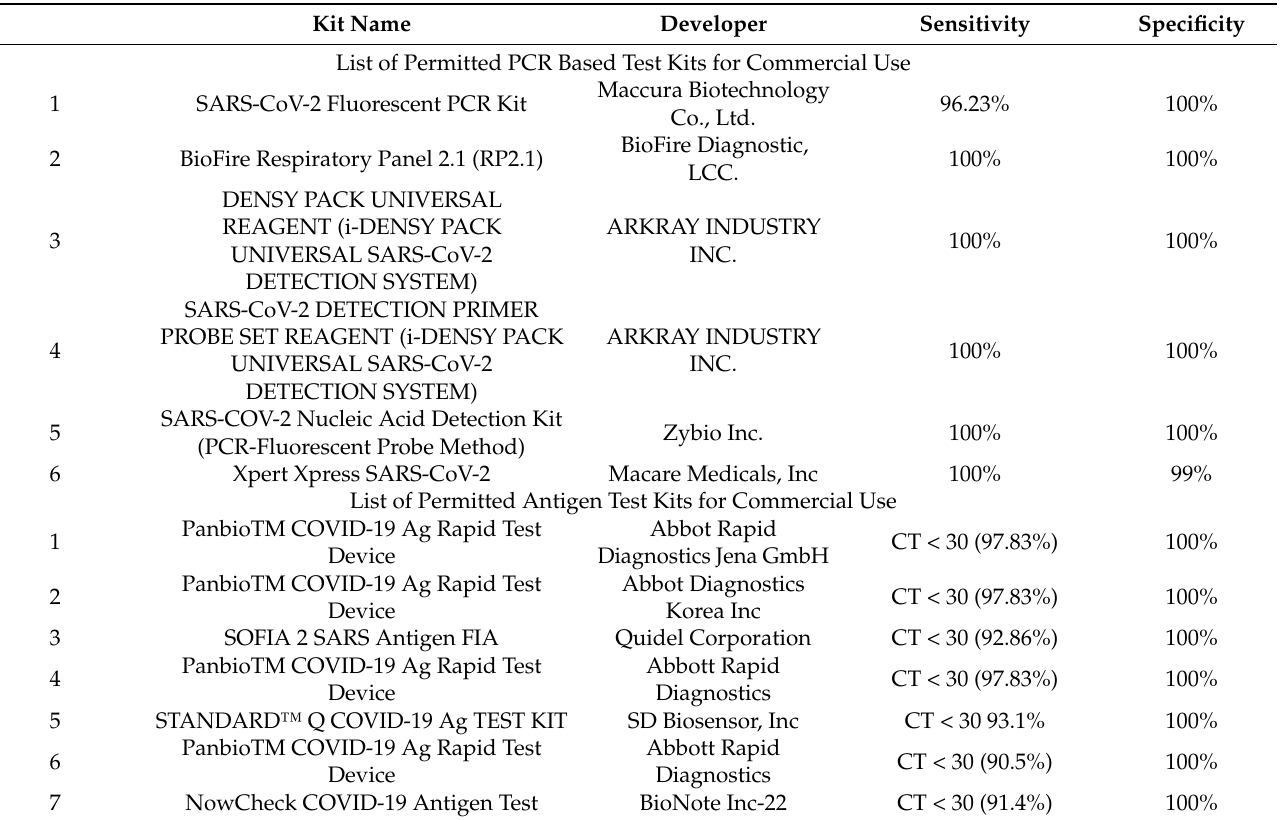
Table 3. List of kits for SARS-CoV-19 approved by FDA